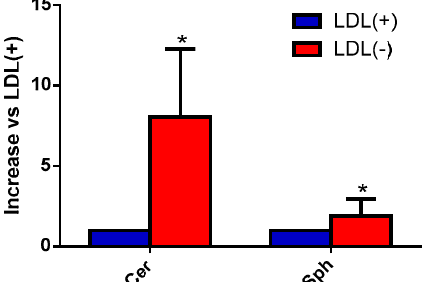
Figure 1. Sphingosine (Sph) and ceramide (Cer) basal content in low-density lipoprotein (LDL) subfractions. Native LDL( + ) (blue bars) and negative LDL( − ) (red bars) (32 µ g of apolipoprotein B (apoB) were analyzed by mass spectrometry to evaluate the baseline levels of sphingolipids. Cer includes all the Cer species that were evaluated. Results are expressed as a relative increase versus LDL( + ), mean ± SD ( n = 4), * vs. LDL( + ), p < 0.05.